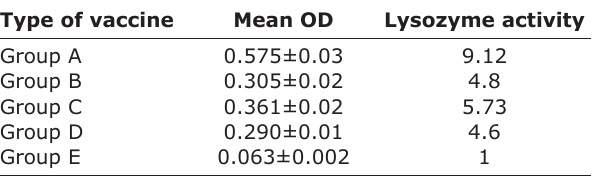
Table-3: Mean OD value of lymphocyte proliferation response after 4 weeks from a